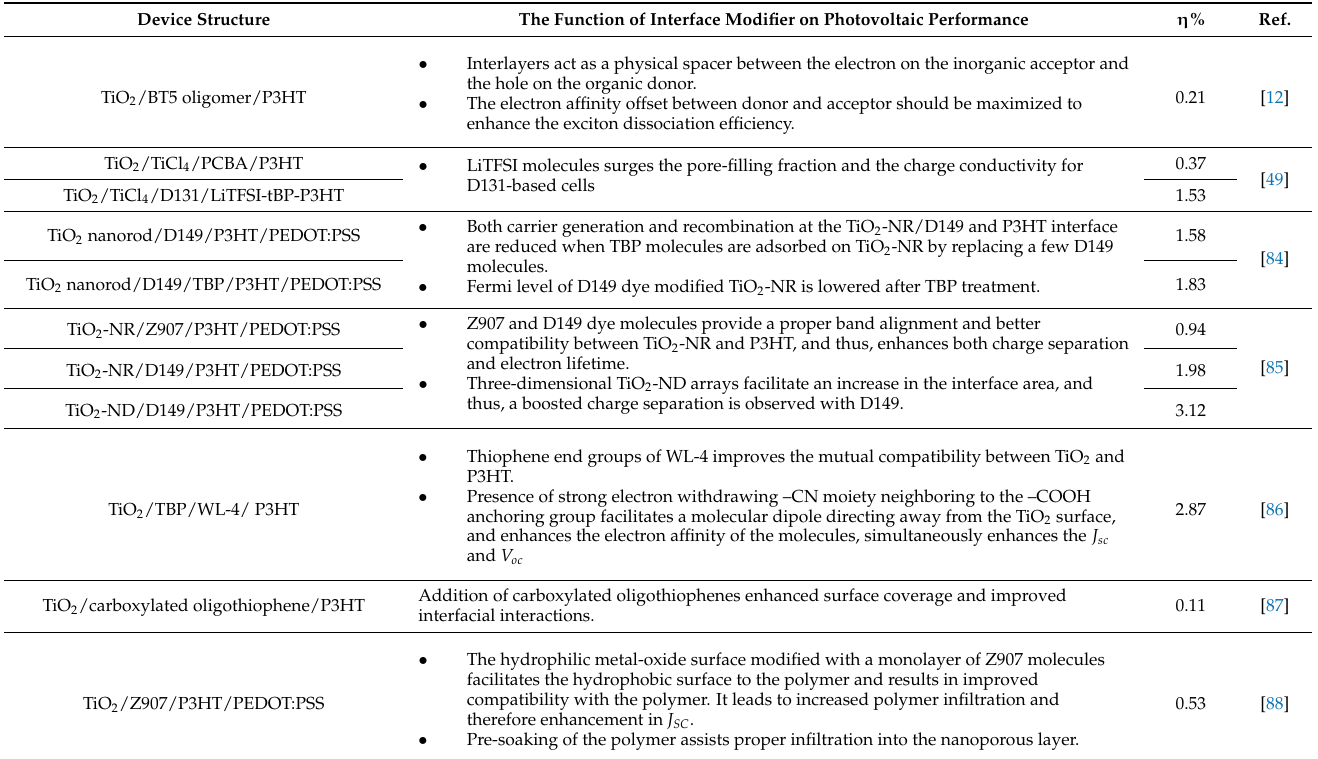
Table 4. Small molecule sensitizers as interfacial modifiers in hybrid Titanium dioxide/Poly(3- hexylthiophene) heterojunction solar